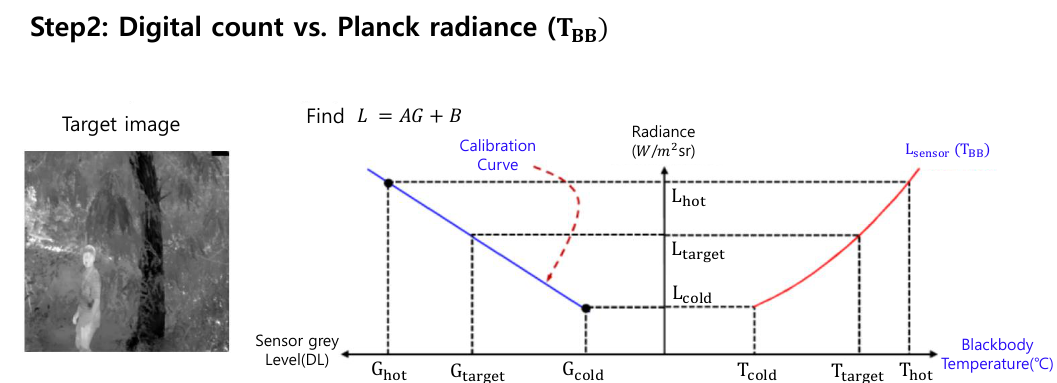
Figure 4. Digital count versus Planck